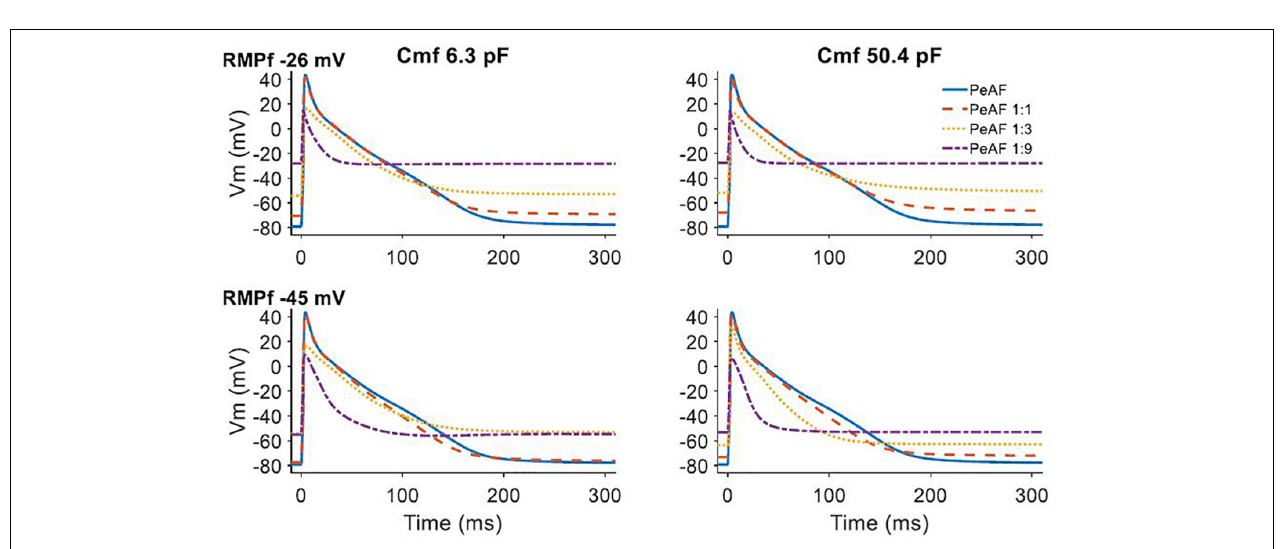
FIGURE 1 | Myocyte action potentials from four different regions of the atria: right atria (RA), left atria (LA), pulmonary vein (PV), and crista terminalis (CT). (A) Myocyte action potentials under normal sinus rhythm (nSR). (B) Myocyte action potentials under the effect of electrical remodeling during persistent atrial fibrillation (PeAF). (C) Myocyte action potential duration (APD 90 ) under nSR and PeAF. (D) Myocyte action potential maximum upstroke velocity (dV/dt max ) under nSR and PeAF. (E) Myocyte action potential resting membrane potential (RMP) under nSR and PeAF.